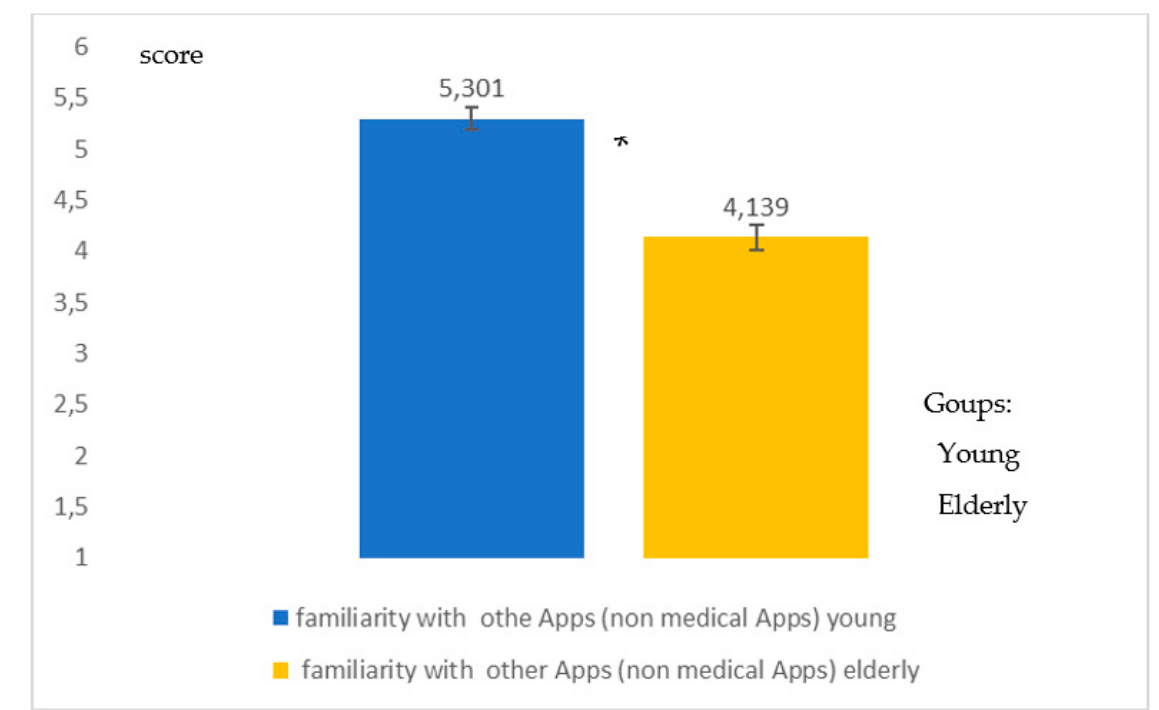
Figure 7. Difference in the degree of familiarity with the App Immuni for DCT for young people and the elderly. The graphic indicates a high difference ( p = 0.008) between the two groups of young * and elderly people.